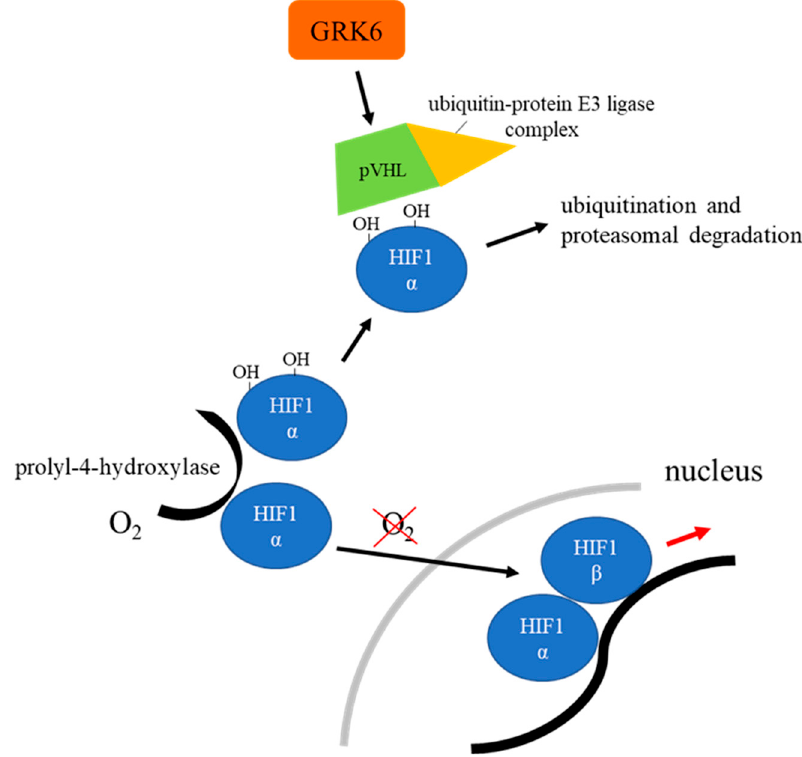
Figure 5. Regulatory cascade of HIF1 α (simplified chart). In normoxia, hydroxylated HIF1 α is bound by pVHL, which initiates its downregulation. GRK6 seems to have a stabilizing effect on pVHL. Under hypoxic conditions, however, HIF1 α dimerizes with HIF1 β and induces gene transcription [91,92].